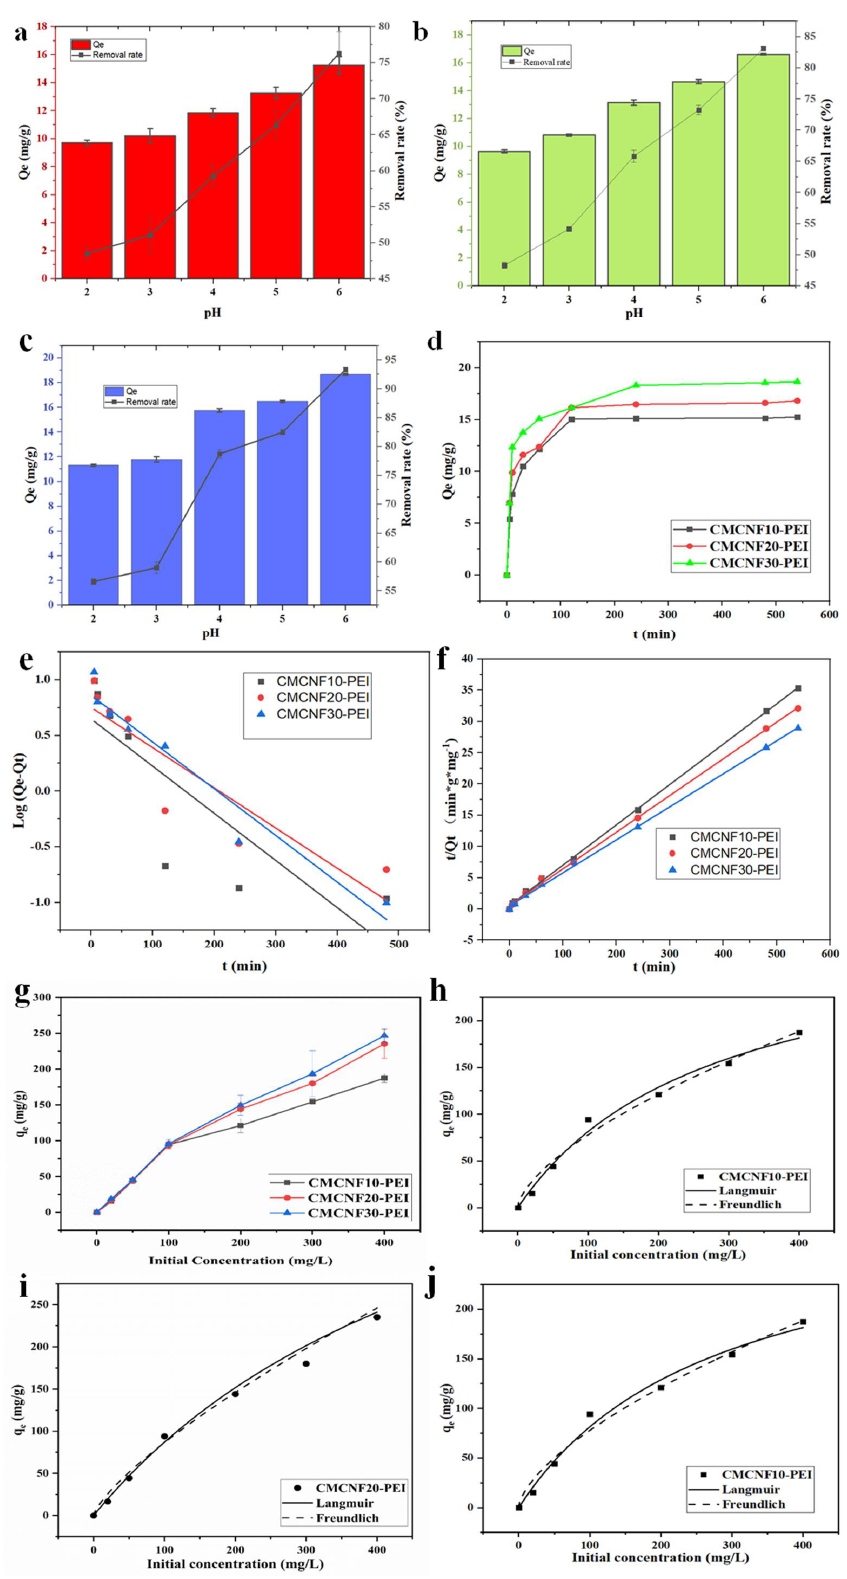
Figure 4. Effect of initial pH on Cu 2+ adsorption; ( a ) CMCNF10-PEI ( b ) CMCNF20-PEI ( c ) CMCNF30- PEI. ( d ) Contact time removal capacity for Cu 2+ adsorption (pH = 6, C 0 = 20 mg/L, T = 25 ◦ C). ( e ) Plots of pseudo-first-order, and ( f ) pseudo-second-order of CMCNF10-PEI, CMCNF20-PEI, CMCNF30-PEI. ( g ) Effect of different initial concentration on Cu 2+ adsorption of three CMCNFs-PEI (pH = 6, t = 24 h, T = 25 ◦ C). ( h ) CMCNF10, ( i ) CMCNF20-PEI, ( j ) CMCNF30-PEI isotherm model for Cu 2+